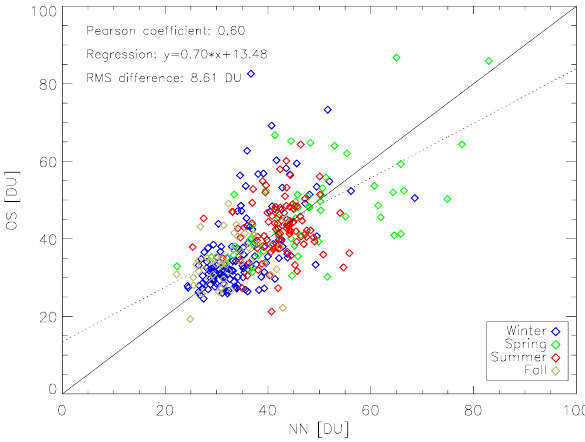
Fig. 4. Scatter plot of OMI-TOC NN retrievals versus correspond- ing OS TOCs for the test data set, in cloud-free conditions. Seasons are plotted in different colors (see